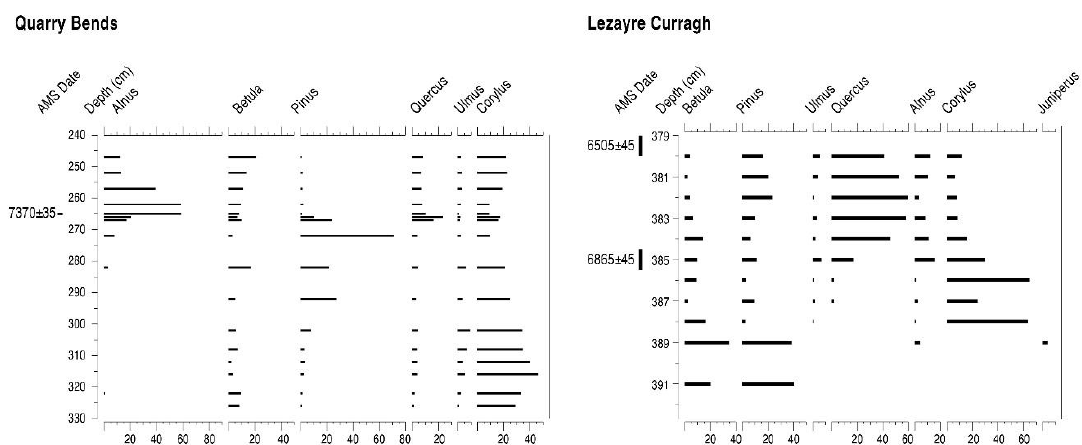
Figure 7. Percentage pollen diagrams from Quarry Bends and Lezayre Curragh showing selected tree taxa and 14 C BP AMS ages.